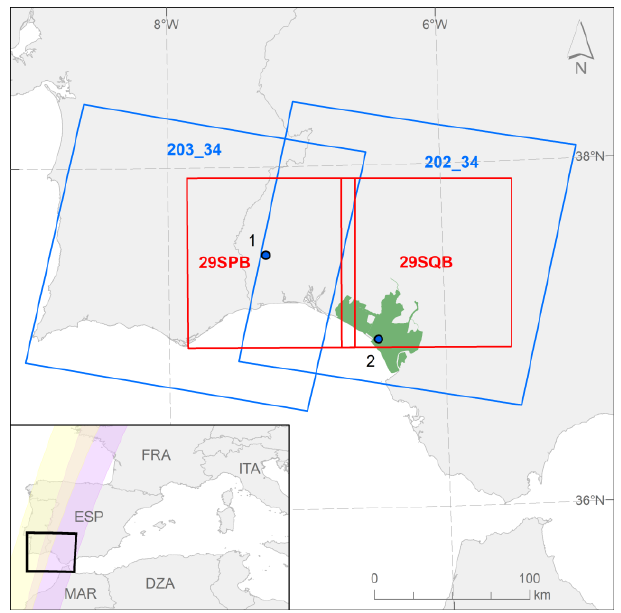
Figure 1. Study area: Doñana National Park in green (Spain, EU), Villanueva de los Castillejos sub-area (1), and Laguna de Santa Olalla sub-area (2). Also shown, Landsat (blue outline) [53] and Sentinel (red outline) scenes [54]. Location map in SW Europe with Sentinel-2 R037 orbit (yellow) and R137 orbit